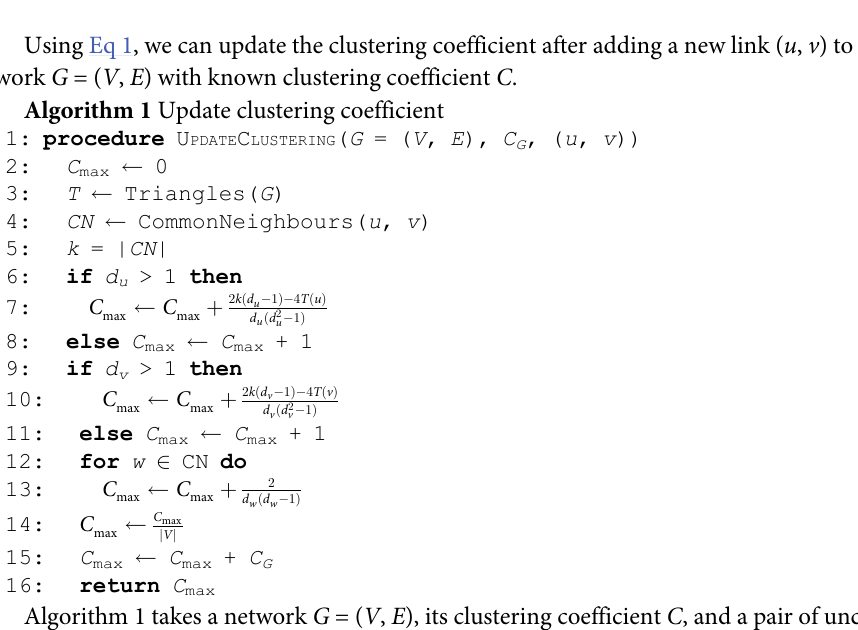
Algorithm 1 takes a network G = ( V , E ), its clustering coefficient C , and a pair of uncon- nected nodes u and v as input and returns the clustering coefficient of the extended network G + uv using Eq 1. It finds the set of common neighbours of u and v , calculates Δ C ( u ) and Δ C ( v ), and then iterates over the set of common neighbours of u and v and increases the sum of for each common neighbour w . The result is then averaged over Δ C ( u ) and Δ C ( v ) by 2 d w ð d w (cid:0) 1 Þ rectness of this algorithm.